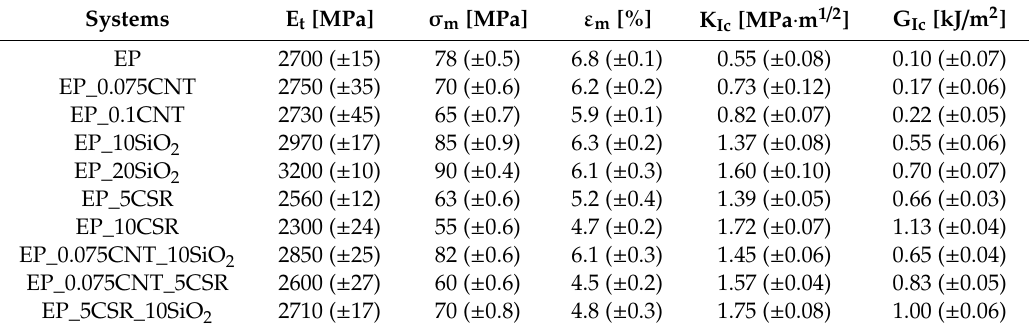
Table 3. Tensile and fracture mechanics properties of reference and modified epoxy systems.